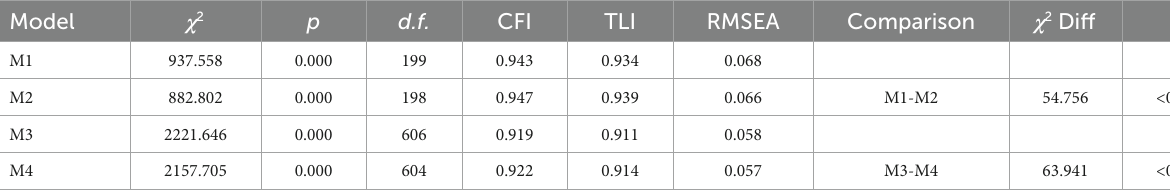
TABLE 8 Fit indices of the structural equation models for study 3. Model χ 2 p d.f. CFI TLI RMSEA